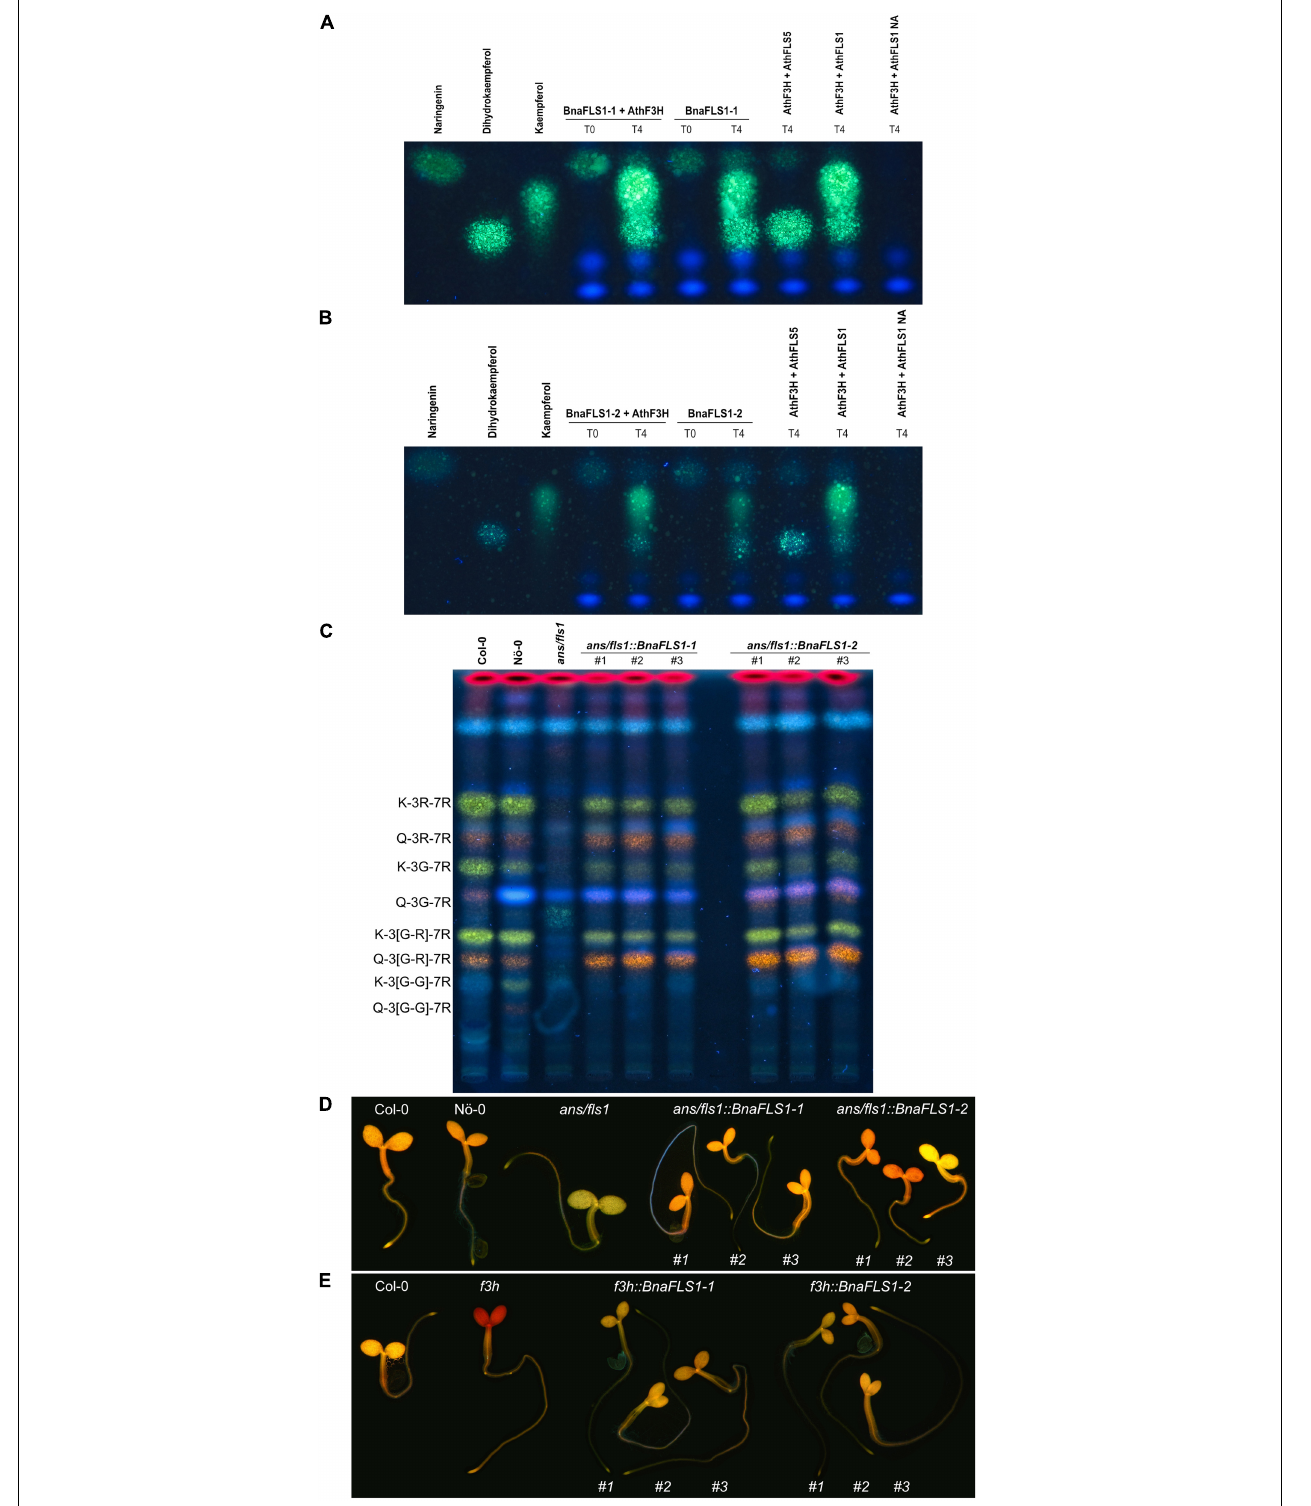
FIGURE 5 | BnaFLS1-1 and BnaFLS1-2 are bifunctional enzymes exhibiting F3H and FLS activity. (A,B) Bioconversion assay results based on a HPTLC using extracts from E. coli expressing recombinant BnaFLS1-1 or BnaFLS1-2. The substrate of F3H naringenin, as well as the FLS substrate dihydrokaempferol and the product kaempferol were used as standards. AthFLS1 served as positive control and AthFLS5 as negative control. In the last sample no Nargingenin (NA) was supplemented. (C) HPTLC on silica gel-60 plates of methanolic extracts of stem of Col-0, Nö-0, ans/fls1 A. thaliana knock out mutant, and three